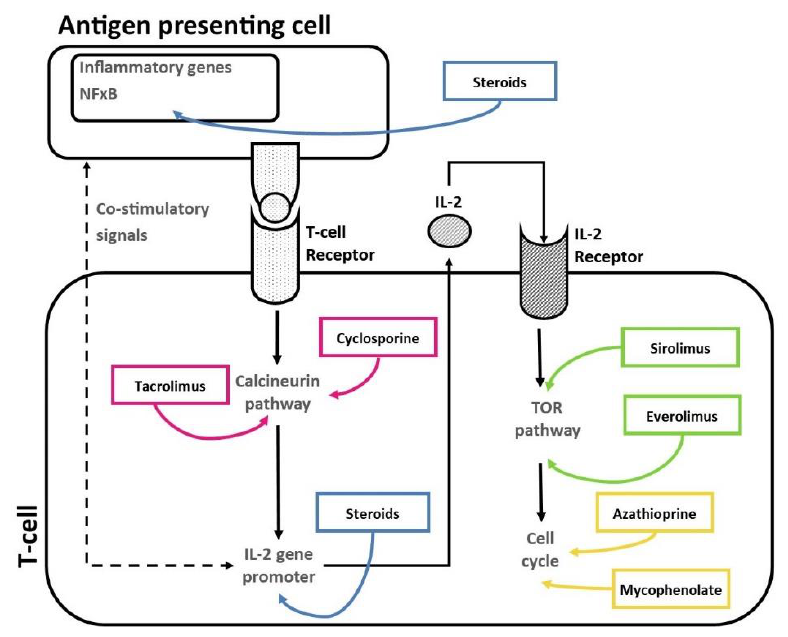
Figure 1. Mechanisms of action of immunosuppressive drugs on patient ’ s T cells.